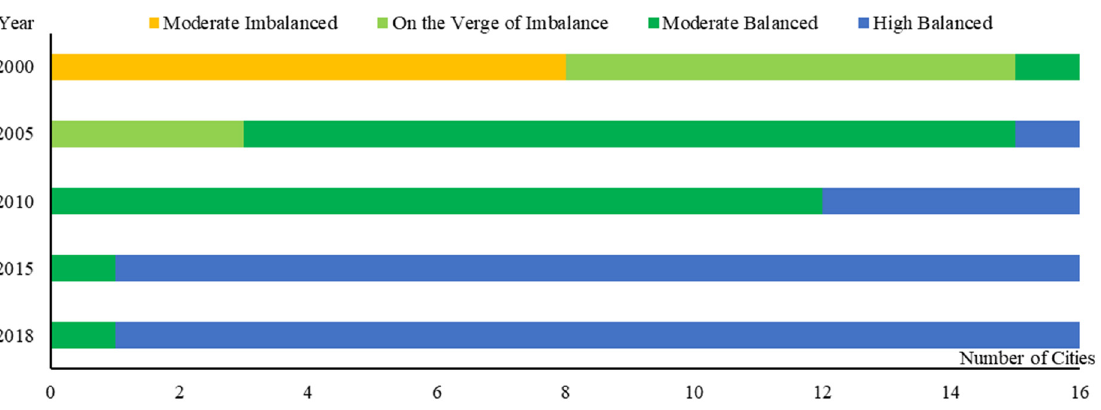
Figure 8. The type of coupling coordination development between new-type urbanization and cultivated land low-carbon utilization of the Yangtze River Delta during 2000–2018.